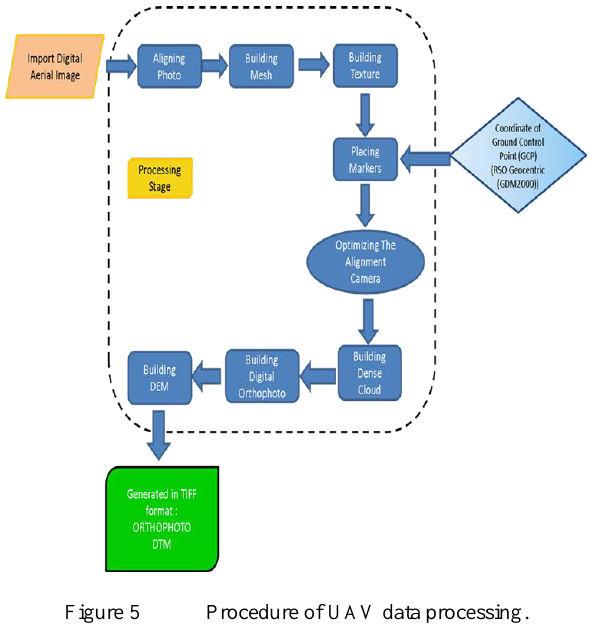
Figure 5 Procedure of UAV data processing.